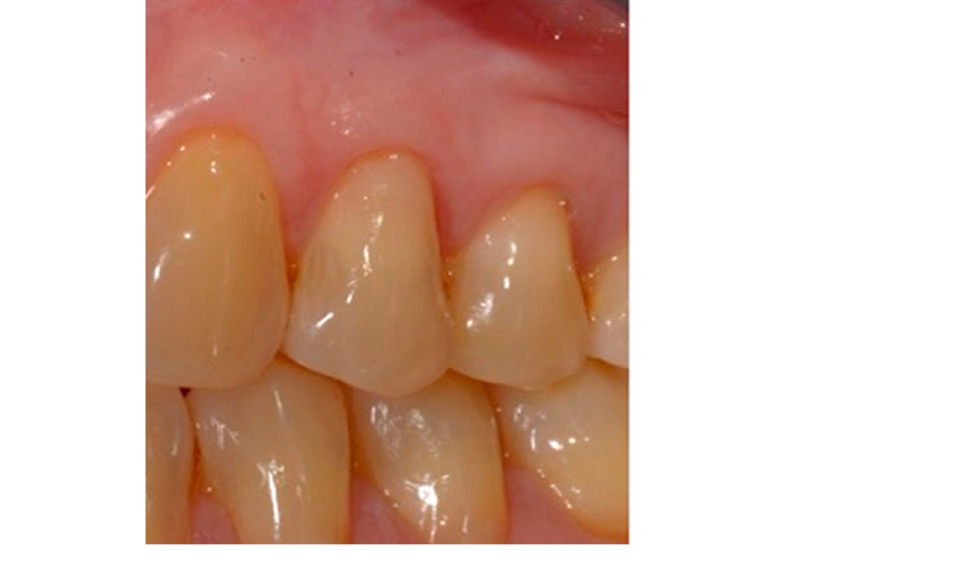
Figure 10. After 15 days from the restoration, the profile was reduced to allow a more coronal gingival adaptation.